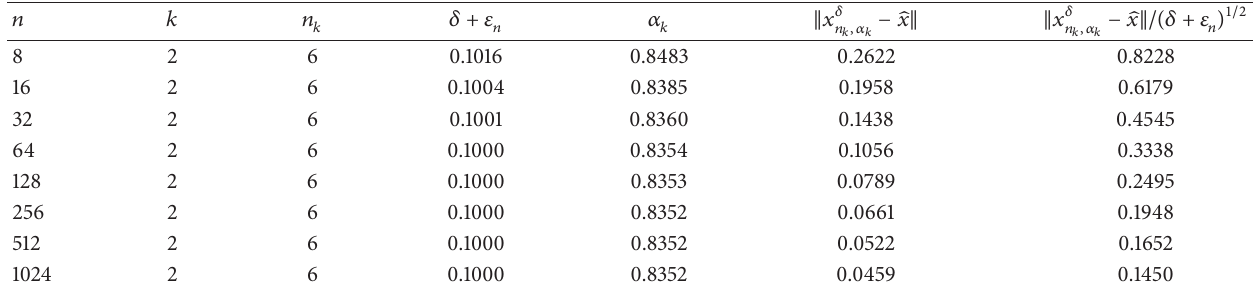
Table 1: Iterations and corresponding error